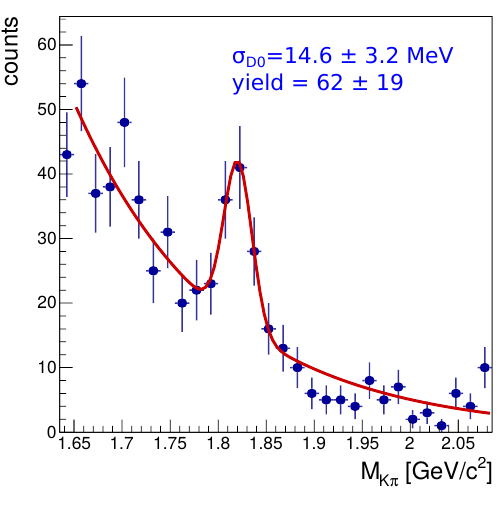
Figure 2. Invariant mass distribution of unlike charge π, K decay track candidates for Pb + Pb collisions at 150 A GeV /